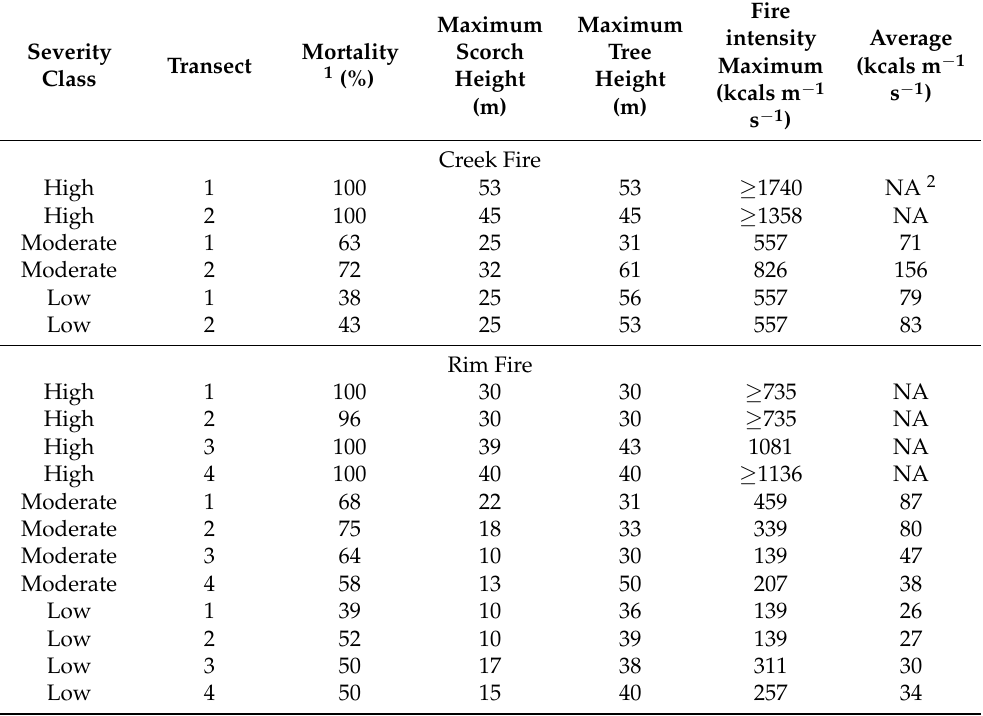
Table 1. Mortality, maximum scorch and tree height, and estimated fire intensities for Creek and Rim fires in California’s Sierra